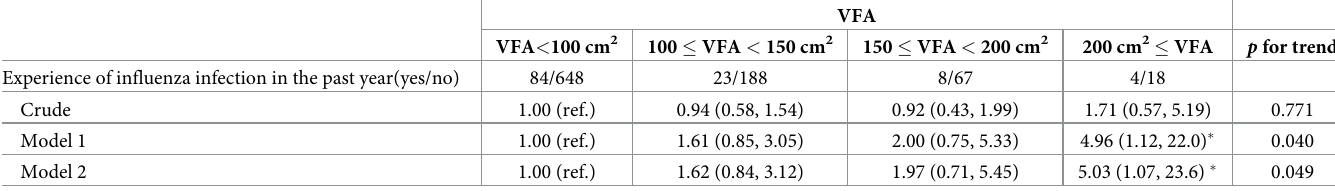
Table 2. Association of visceral fat area (VFA) with influenza infection according to the VFA group in 2019.